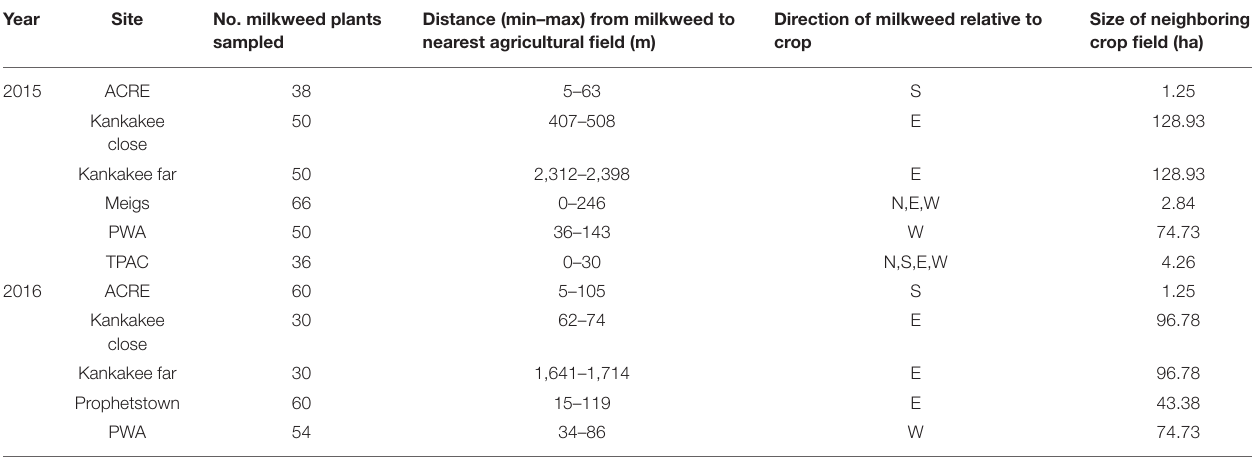
TABLE 2 | Local site characteristics and number of plant replicates for milkweeds sampled in 2015 and